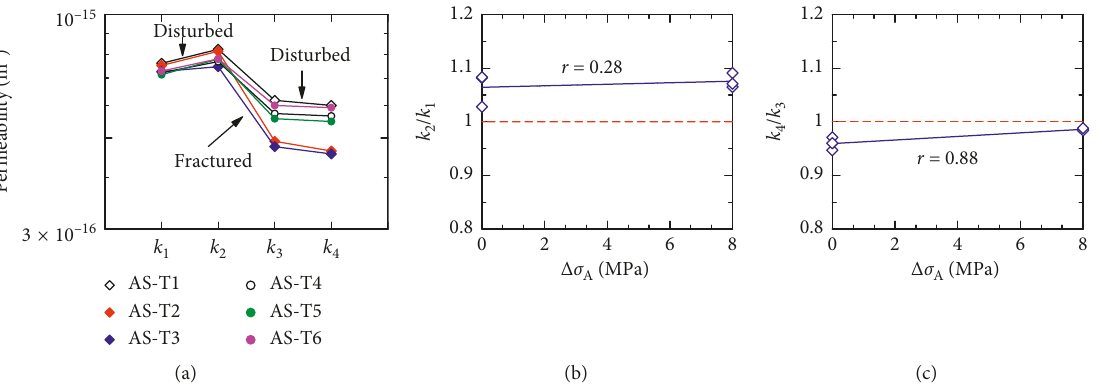
P P ) of the Shikotsu Δ